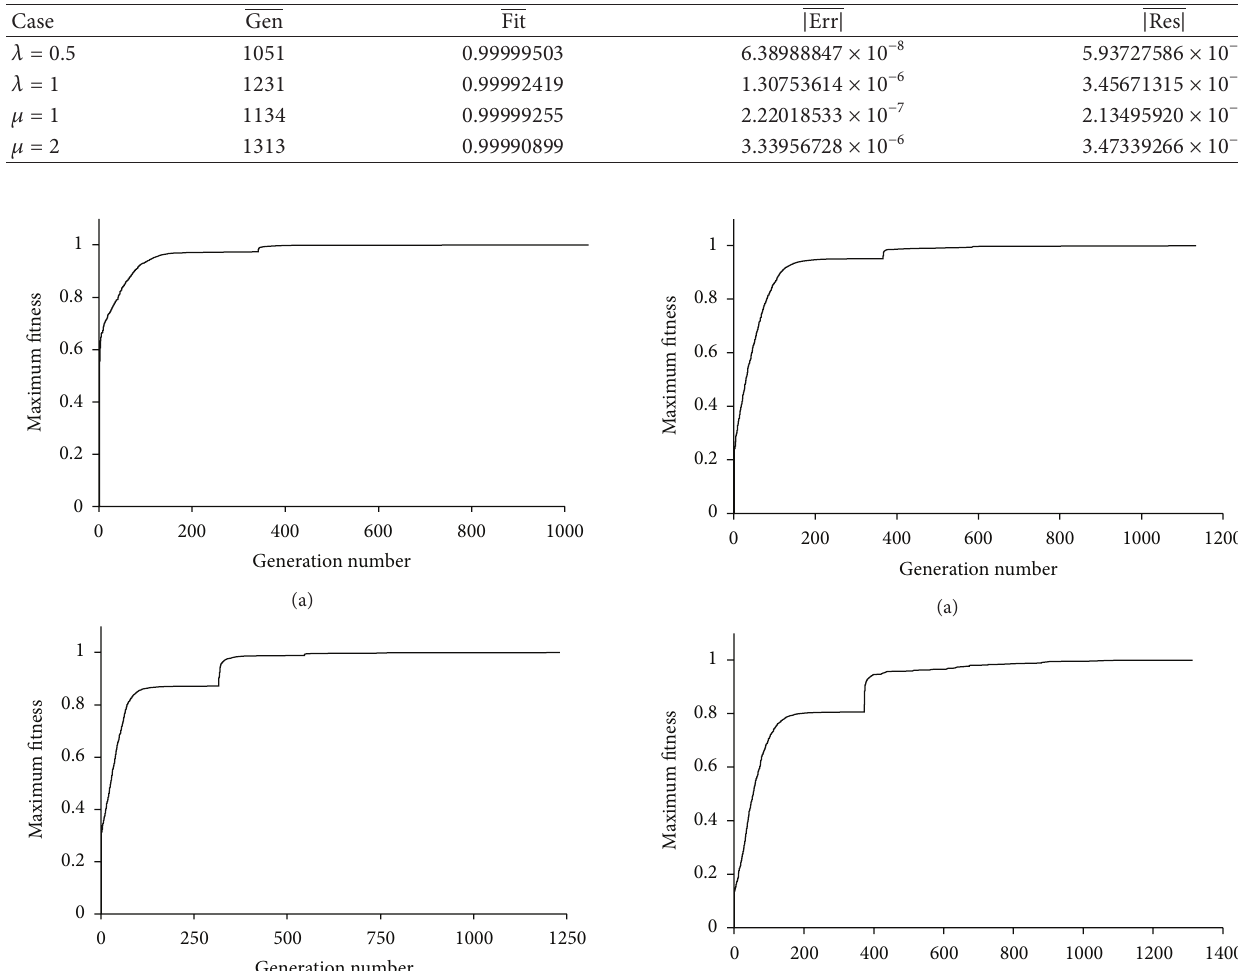
Table 9: Convergence data of Troesch’s and Bratu’s problems.